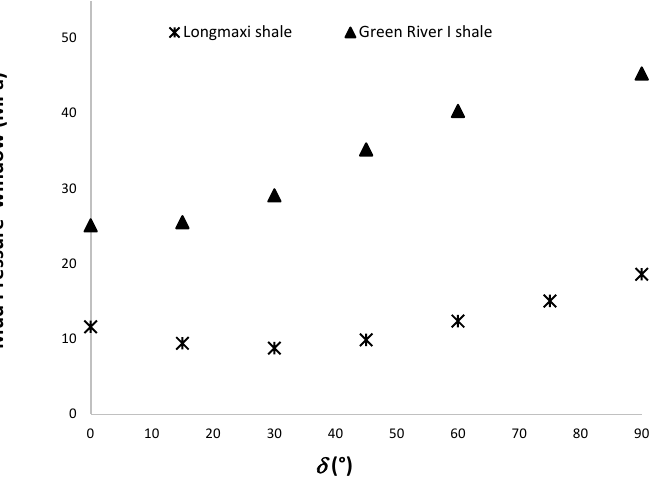
Figure 18. Variation of the mud pressure window with δ .